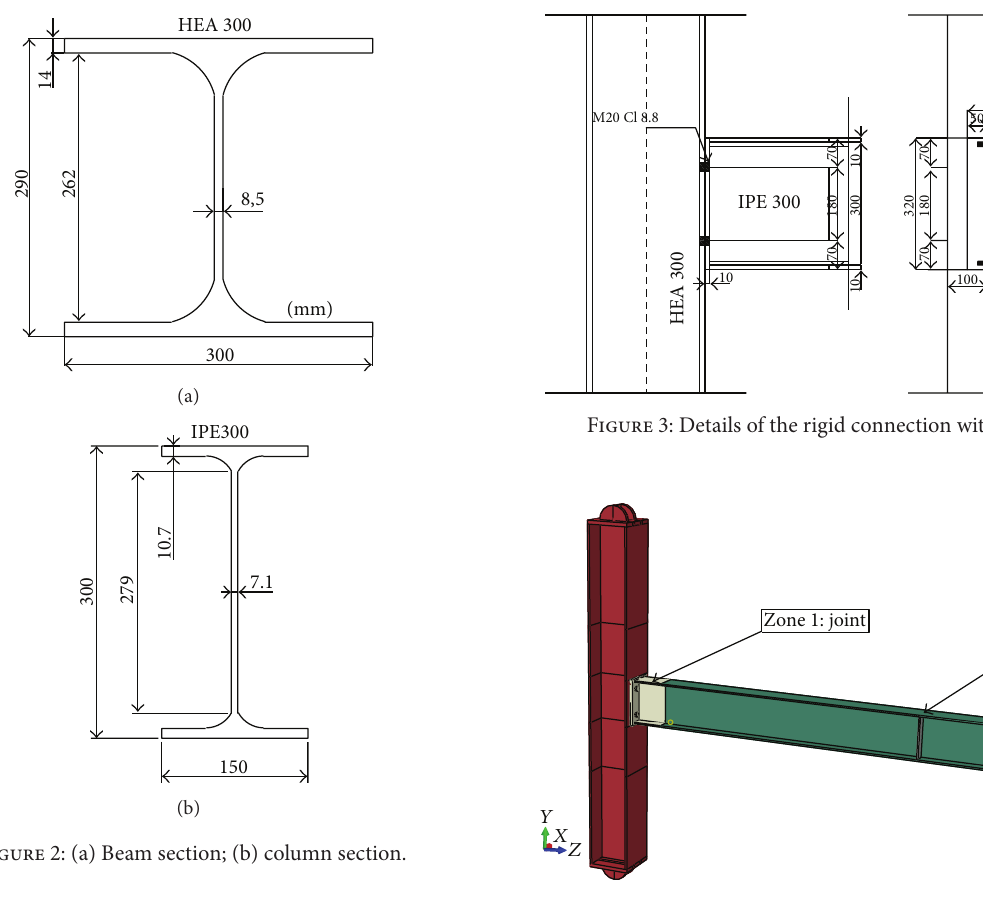
Figure 4: Different heated